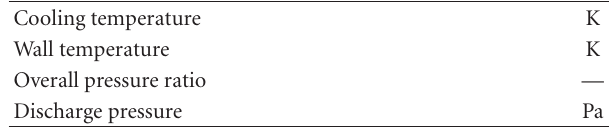
Table 2: Thermodynamic parameter.